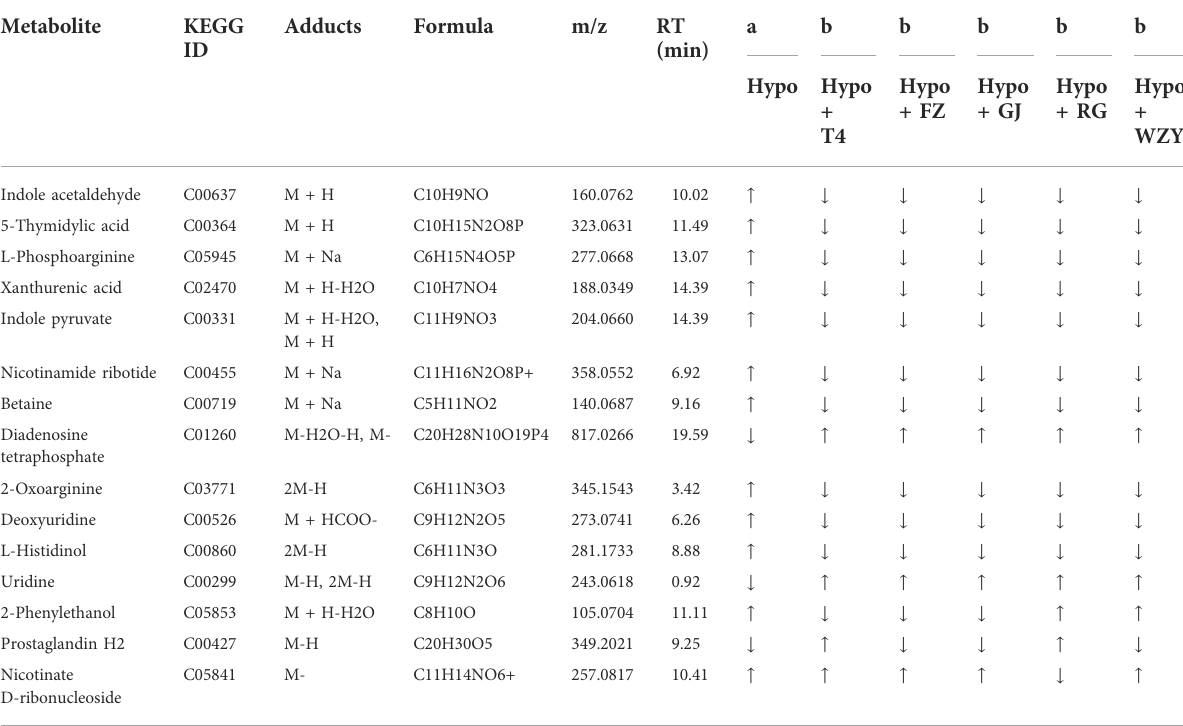
Nicotinate D-ribonucleoside a Represent compared with the control group. b Represent compared with the model group.